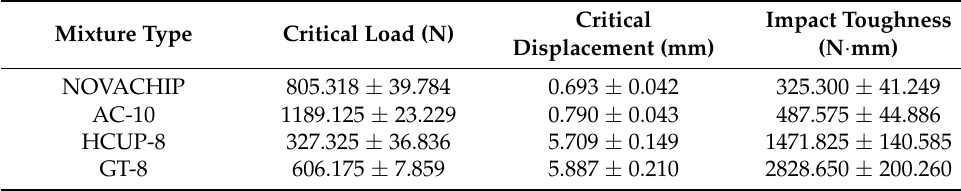
Table 12. Results of impact toughness test.